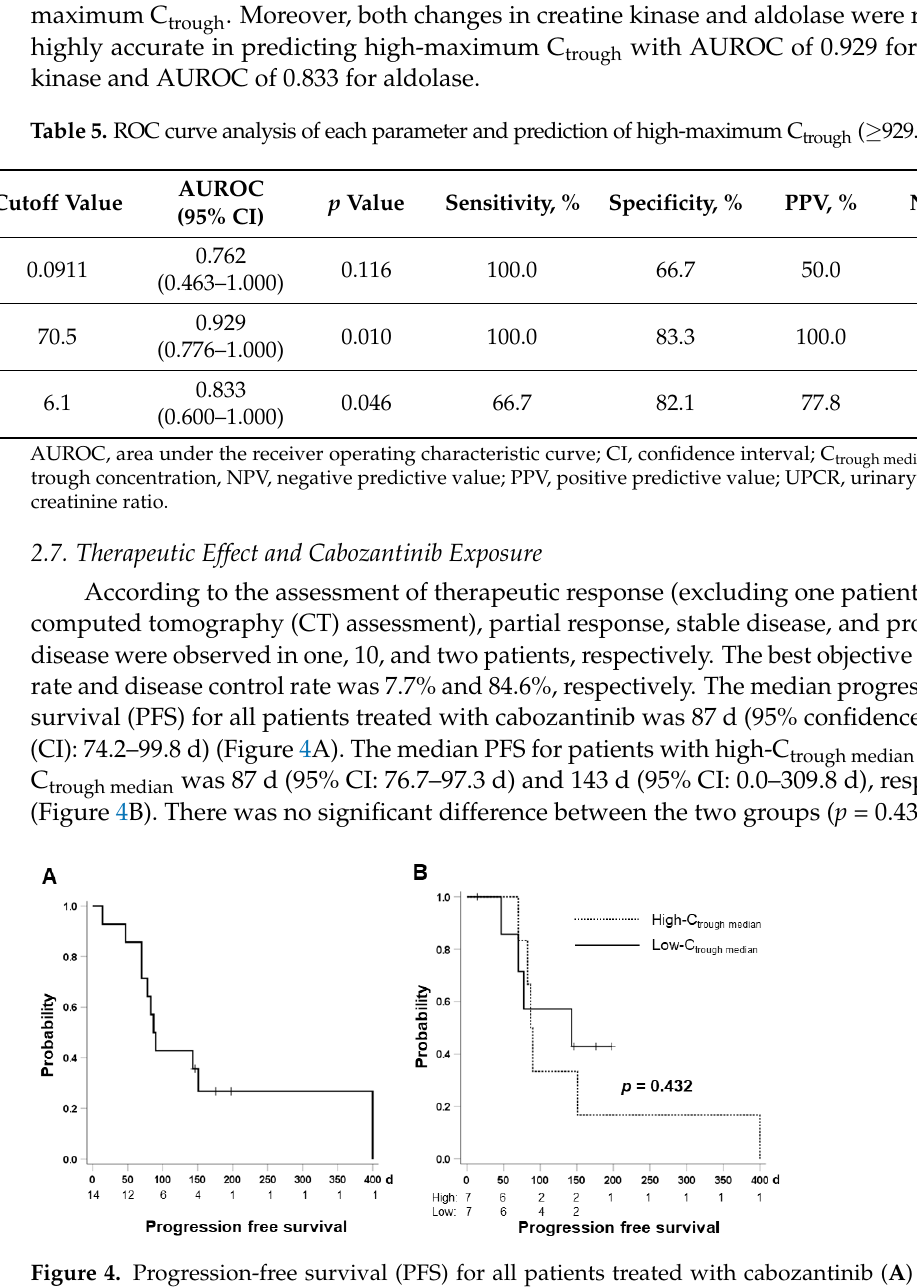
Figure 4. Progression-free survival (PFS) for all patients treated with cabozantinib ( A ) and comparison of the PFS between patients included in the high-C trough median ( ≥ 653.5 ng/mL) and low-C trough median (<653.5 ng/mL) groups ( B ).